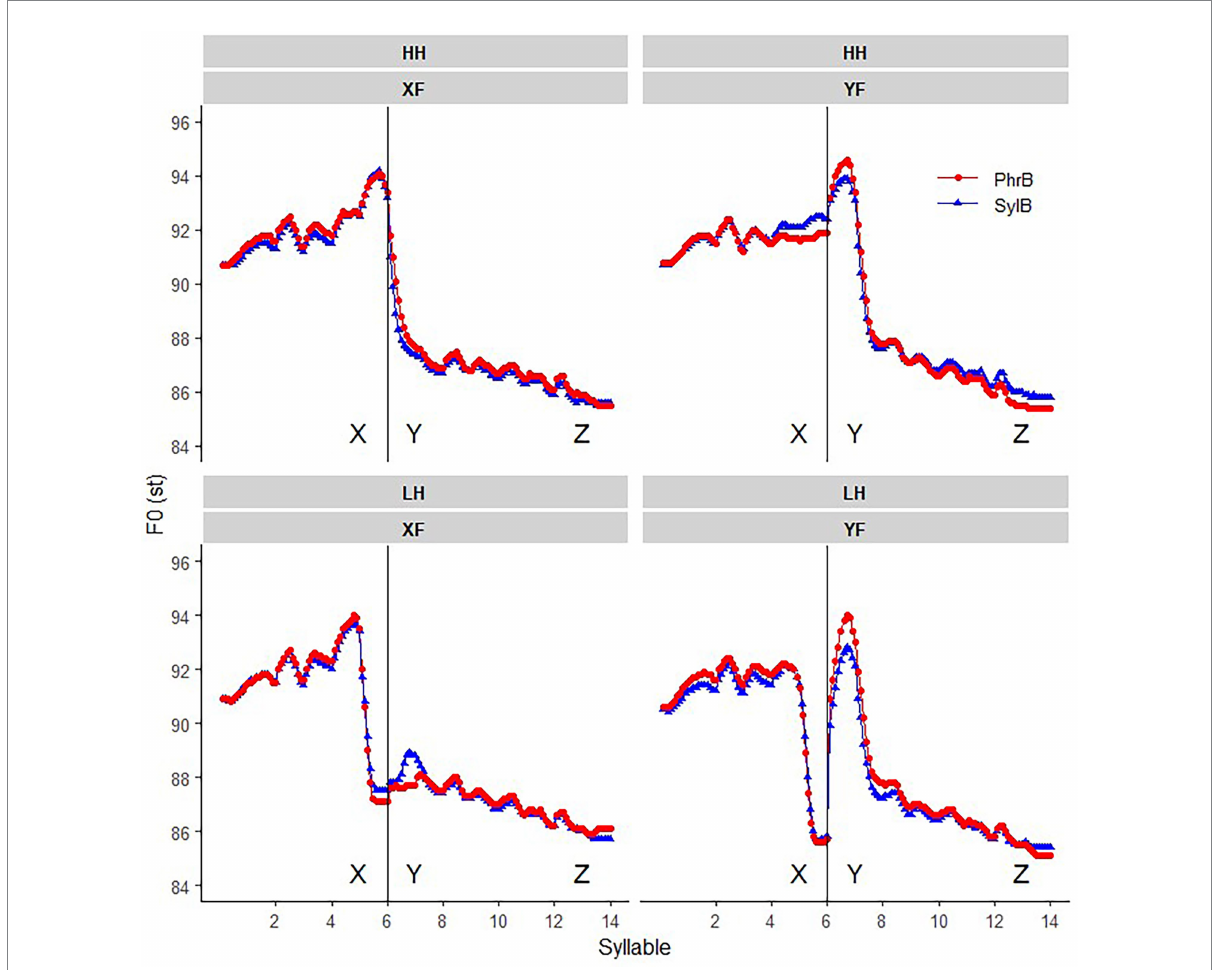
FIGURE 3 The time-normalized intonation contours of the two boundary conditions in the HH and the LH sentences under the XF and YF conditions. Here SylB and PhrB stand for syllable and phrase boundary between syllable X and Y. The x -axis are the syllable